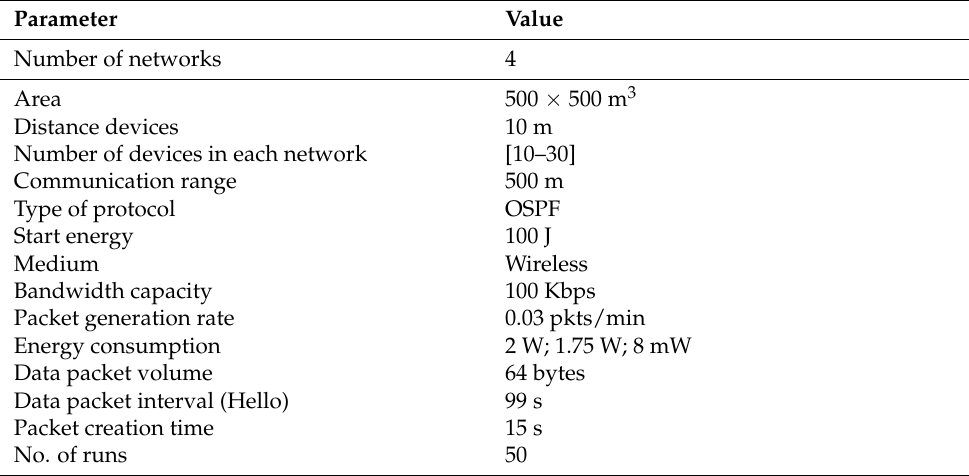
Table 2. Simulation setting